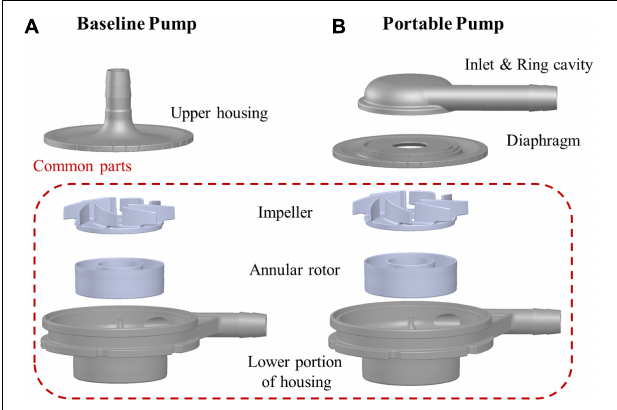
FIGURE 1 | Exploded view of baseline blood pump (A) and portable blood pump (B) .